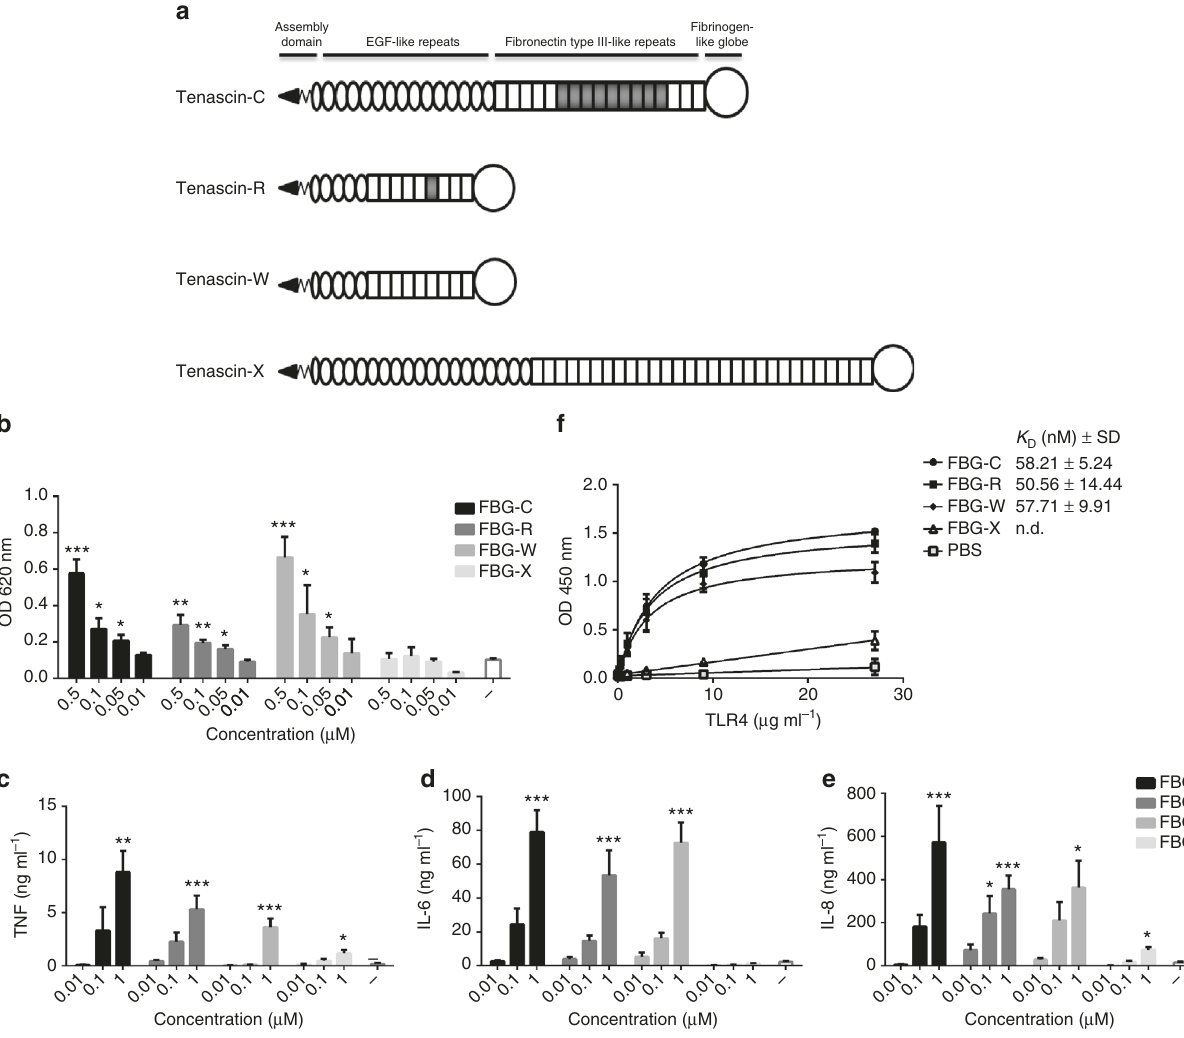
Fig. 1 The FBG domains of tenascin-C, -R, and -W can induce NF-kB activation and cytokine synthesis, and bind to TLR4. a Tenascin-C, -R, -W, and -X each contain an assembly domain, a variable number of epidermal growth factor (EGF)-like repeats, a variable number of fi bronectin type III-like repeats (these can be constitutively expressed (white rectangles) or alternatively spliced (gray rectangles) and a C-terminal fi brinogen-like globe (FBG) domain. The FBG domains exhibit a similar molecular weight, comprising between 229 and 240 amino acids each (FBG-C: 26.1 kDa, amino acids 1974 – 2201, FBG-R: 27.0 kDa, amino acids 1128 – 1359, FBG-W: 27.5 kDa, amino acids 1060 – 1300, FBG-X: 26.1 kDa, amino acids 4013 – 4243); protein accession numbers: tenascin-C (P24821), tenascin-R (Q92752), tenascin-W (Q9UQP3), tenascin-X (P22105). b THP1 NF-kB cells were stimulated with different concentrations of FBG-C, -R, -W, and -X, or were left unstimulated ( − ) for 24 h and NF-kB activation measured using QUANTI-Blue. Data are shown as mean ± SEM from three independent experiments. One-way ANOVA vs. non-stimulated, ** p < 0.01, *** p < 0.001. c – e Primary human macrophages were stimulated with different concentrations of FBG-C,-R, -W, and -X, or were left unstimulated ( − ) for 24 h, and TNF ( c ), IL-6 ( d ), and IL-8 ( e ) levels measured by ELISA. Data are shown as mean ± SEM from three independent donors. One-way ANOVA vs. non-stimulated, * p < 0.05, ** p < 0.01, *** p < 0.001. f 96-well plates were coated with 1 µ g ml − 1 of FBG-C, -R, -W, or -X, or PBS, and incubated with increasing doses of TLR4. Curves were fi tted in GraphPad Prism using one-binding site hyperbola equation. Data in the graph are shown as mean ± SEM from four independent